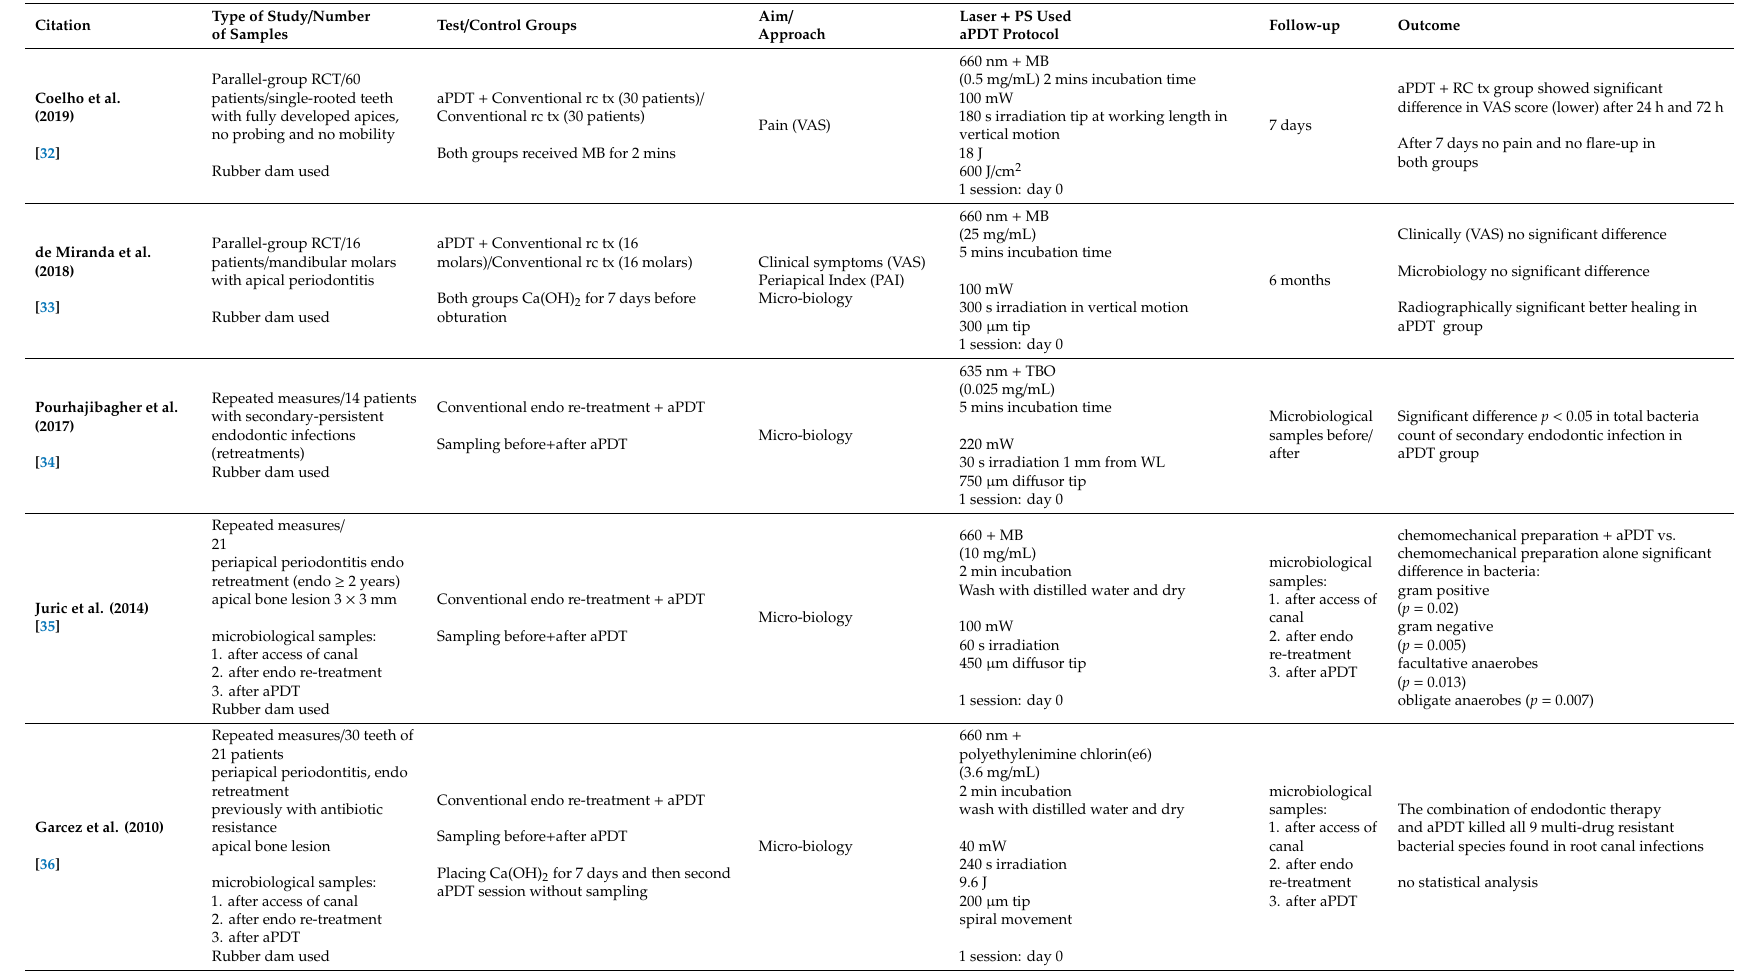
Table 2. Antimicrobial photodynamic therapy (aPDT) in endodontic